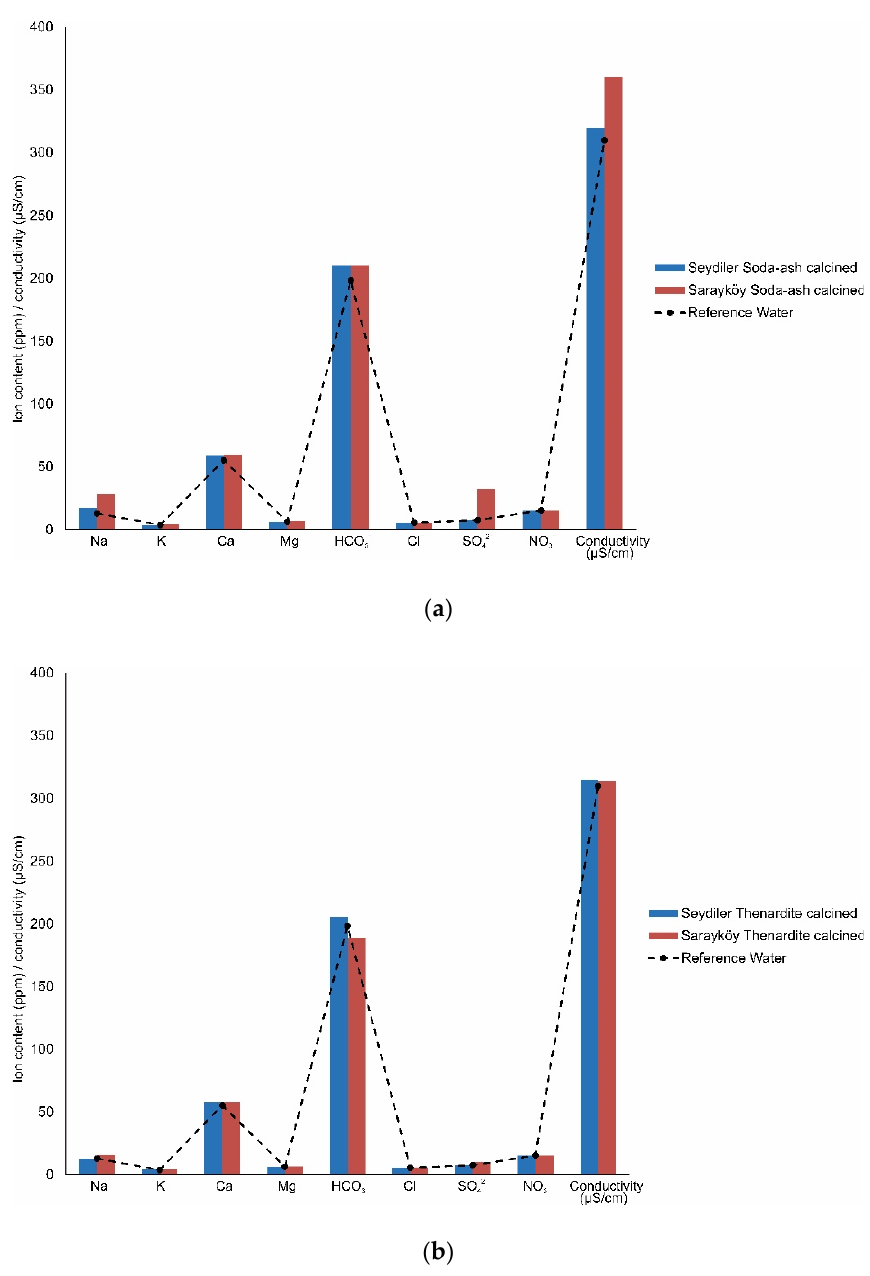
Figure 11. Chemical analysis of filtrates after permeability tests. The dashed line shows the results for the water before filtration. Representative ions and conductivity values of filtrates filtered by ( a ) soda ash calcined and ( b ) thenardite calcined diatomite samples.